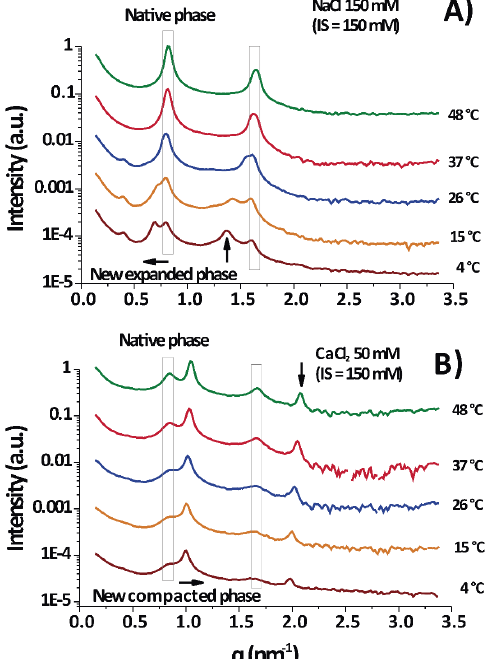
Figure 1. Diffraction signals of purified myelin membranes (PMMs) at different temperatures and in different aqueous conditions. ( A ) Under near physiological conditions (NaCl 150 mM) and (B) at high CaCl 2 (50 mM, equal ionic strength (IS) to A). In (A), the major Bragg peaks of myelin (at 0.8 and 1.6 nm − 1 ) were the only peaks present at 37–48 ◦ C (surrounded in a vertical rectangle), but under cooling a new phase appeared with a peak at lower q (arrow pointing to the left), which coincided with higher d —an expanded phase. In ( B ), the native peak appeared again (inside the rectangle), and additionally a new Bragg peak at higher q appeared ( ≈ 1 nm − 1 , arrow pointing to the right)—a compacted phase. The second order peaks ( h = 2) associated with the non-native phases are indicated with vertical arrows.